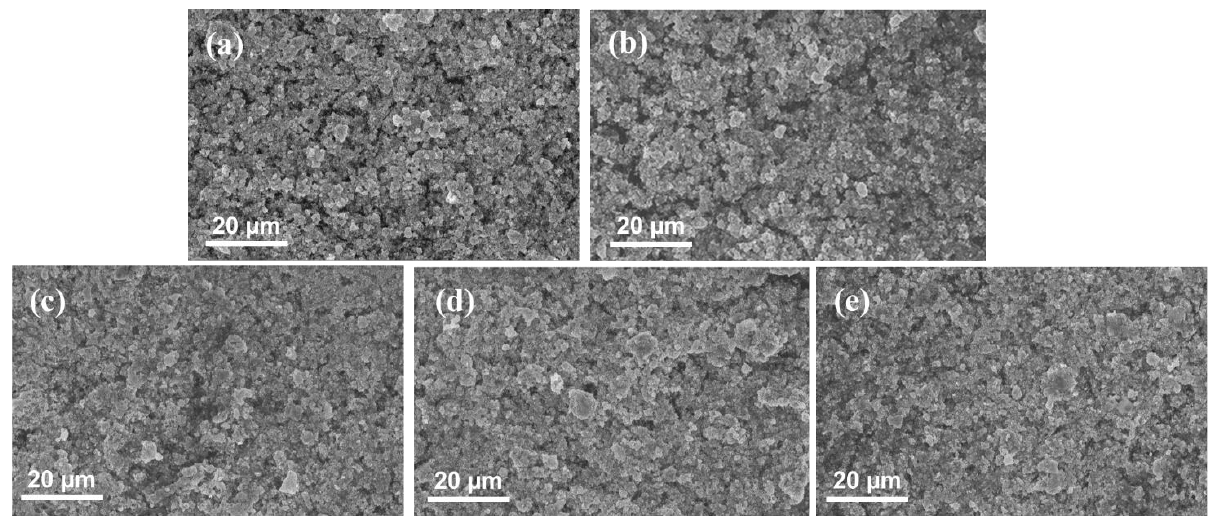
Figure 4. SEM images of various anode electrodes ( a ) SP, ( b ) SP + HP, ( c ) SP + DT, ( d ) RC + DT, ( e ) BC + DT. BC + DT. Table 2. Results comparison between various electrodes in PEMWE. Table 2. Results comparison between various electrodes in